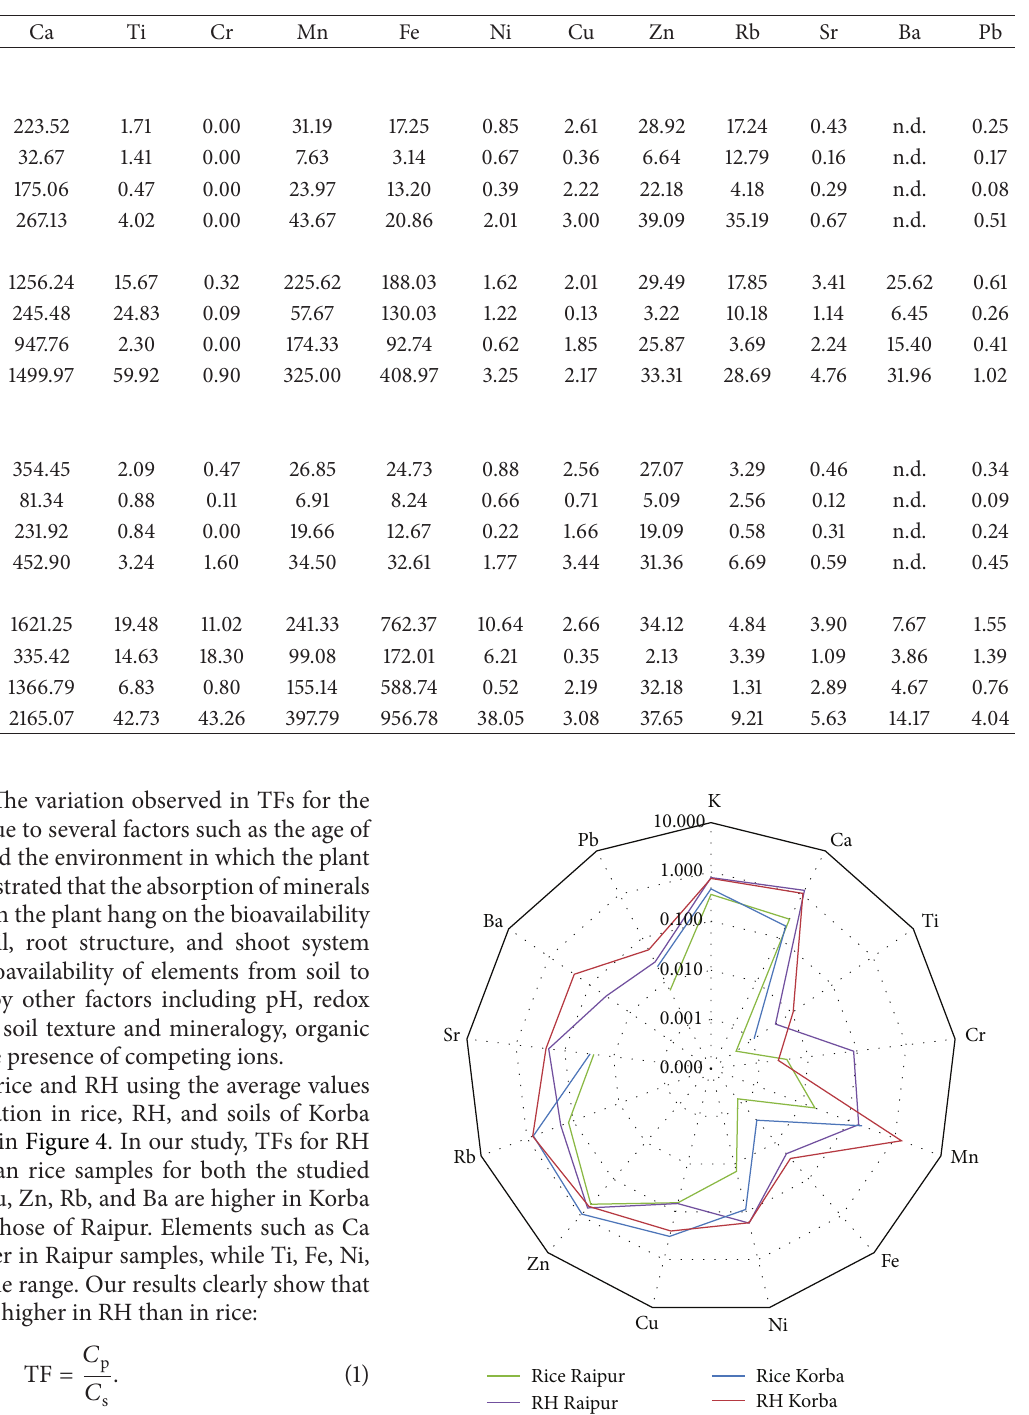
Table 6: Descriptive statistics results of elemental chemical analysis for rice and rice husk from Korba and Raipur.